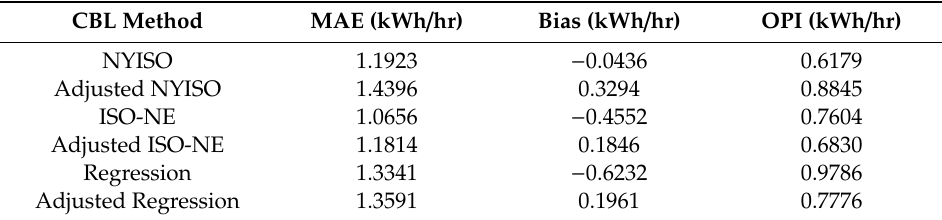
Table 5. Error analysis before load aggregation.